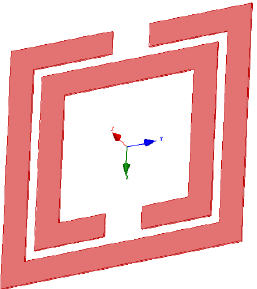
Figure 16. Square SRR designed in HFSS.